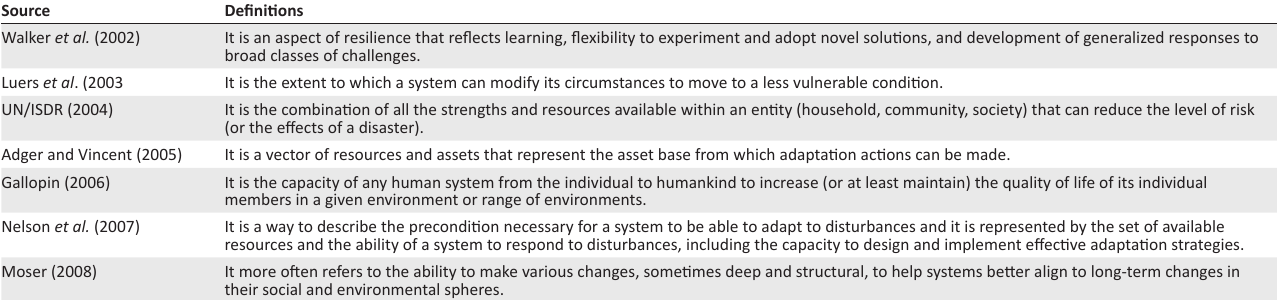
TABLE 1: Definitions of adaptive capacity.